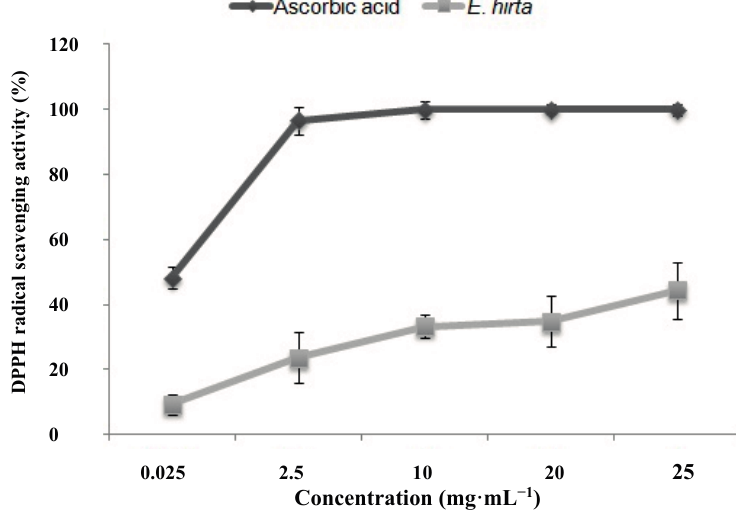
Figure 3. Hydroxyl radical scavenging activity of the ethanol extract of E. hirta . Values are the average of triplicate experiments and represented as mean ±